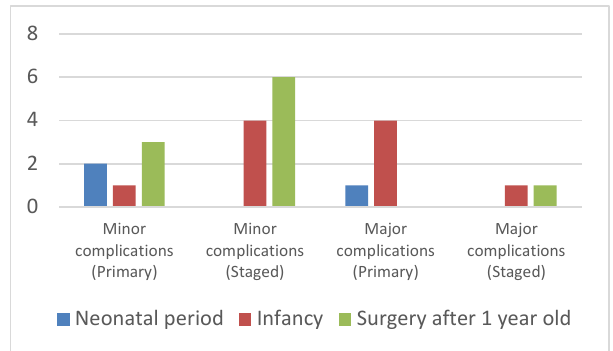
Fig 1: Age-group related perioperative complications